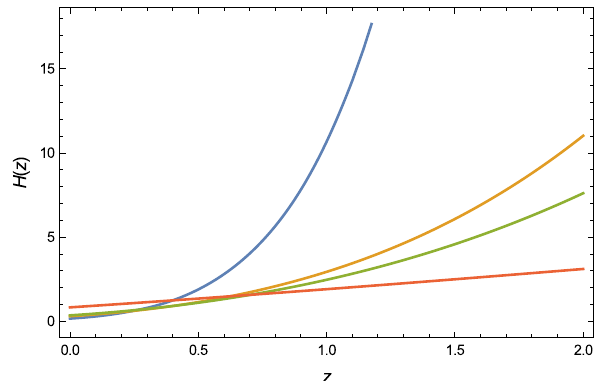
Fig. 14 Evolution of Hubble parameter with respect to redshift for different values of α . Red: α = 3, green: α = 0 . 16, yellow: α = − 0 . 16, blue: α = −